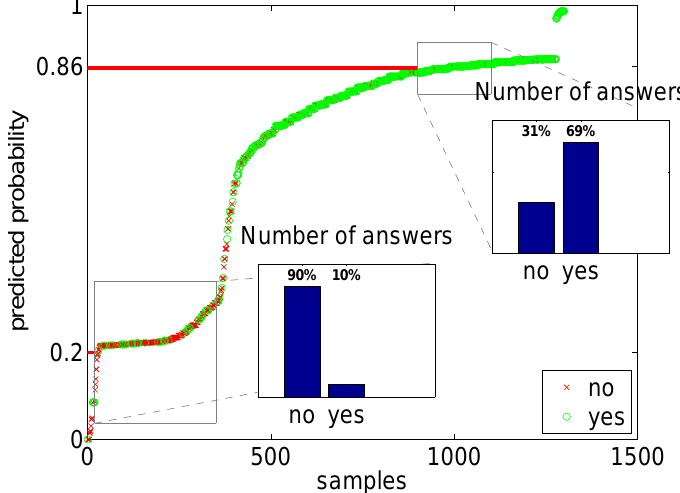
Figure 9. Predicted yes -probability for each sample in the sorted environment